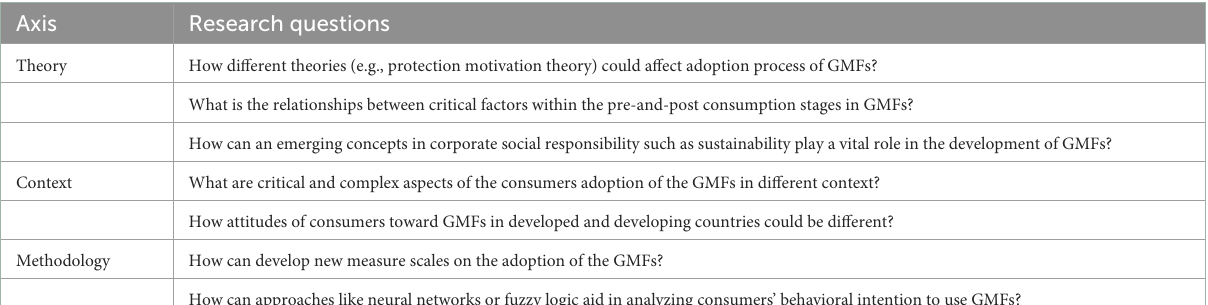
TABLE 10 Future research questions. Axis Research questions